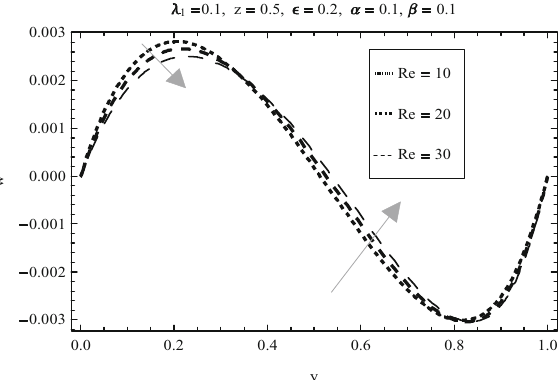
Fig. 13 Velocity component w along y for different values of